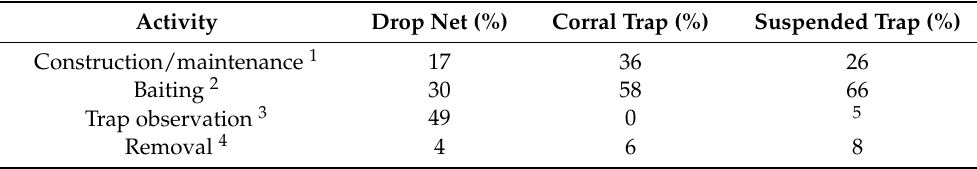
Table 2. Percentage (%) of time spent on various activities while trapping wild pigs ( Sus scrofa ) using drop nets (Coffey and Oswalt Road ranches; 2010–2011), corral traps (Hoffmann and Oswalt Road ranches; 2010–2011), and suspended traps (Coffey, Oswalt and Red River ranches; 2012) in Love County, Oklahoma, USA. Total time for each method was 9.79, 7.2 and 2.92 h for drop nets, corral traps and suspended traps,